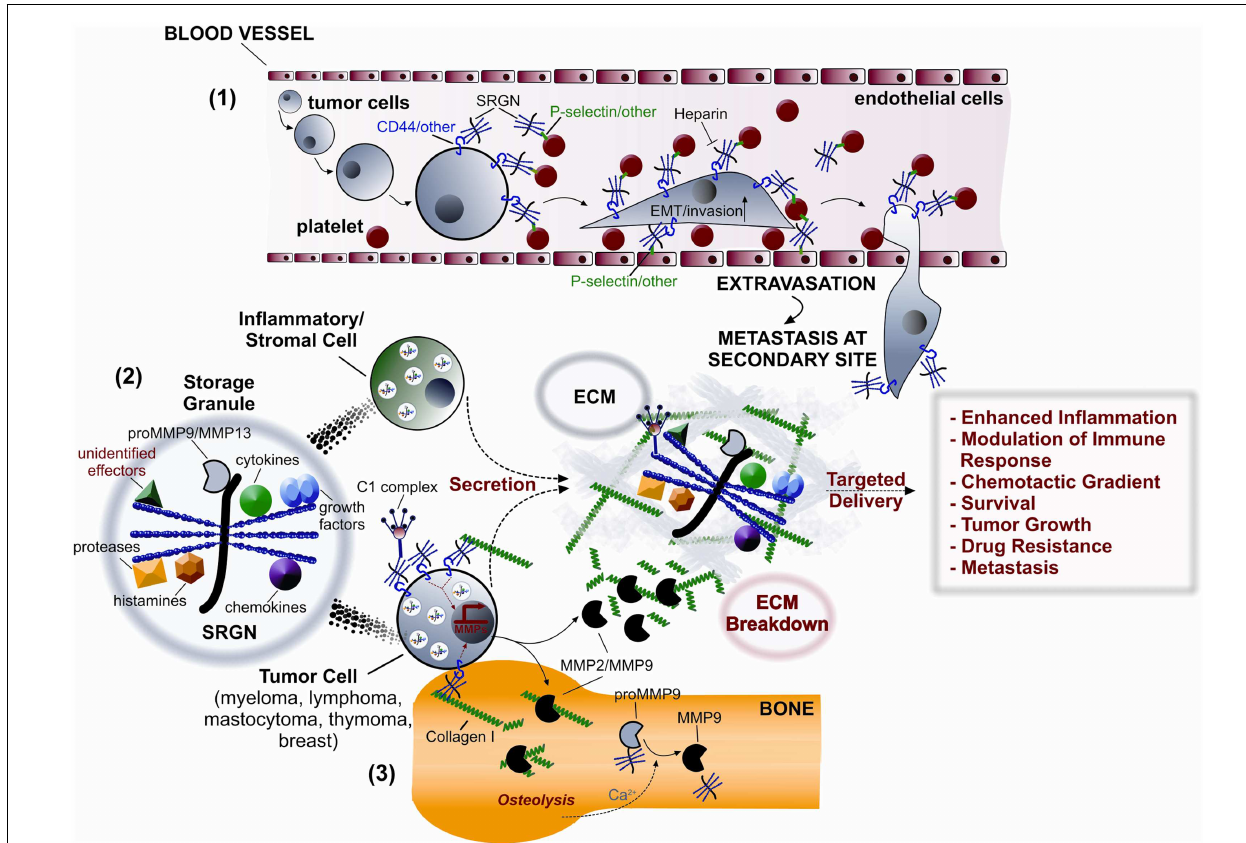
transported to storage granules for subsequent regulated secretion. SRGN-bound molecular effectors (cytokines, chemokines, complement components, growth factors, proteases, MMPs, histamines, and others) are then specifically delivered to target cells, thus controlling inflammation and tumor progression. (3) SRGN present on tumor cell surface promotes their adhesion to collagen I inducing the expression of MMP2/MMP9 resulting in bone destruction and peritumorous ECM